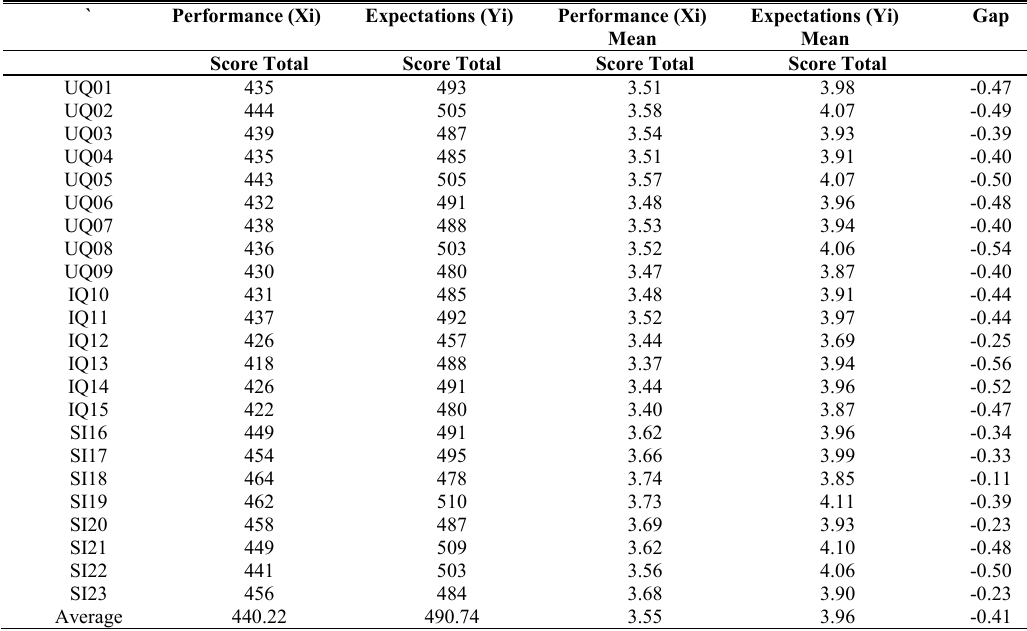
TABLE 5 WEBQUAL 4.0 CALCULATION